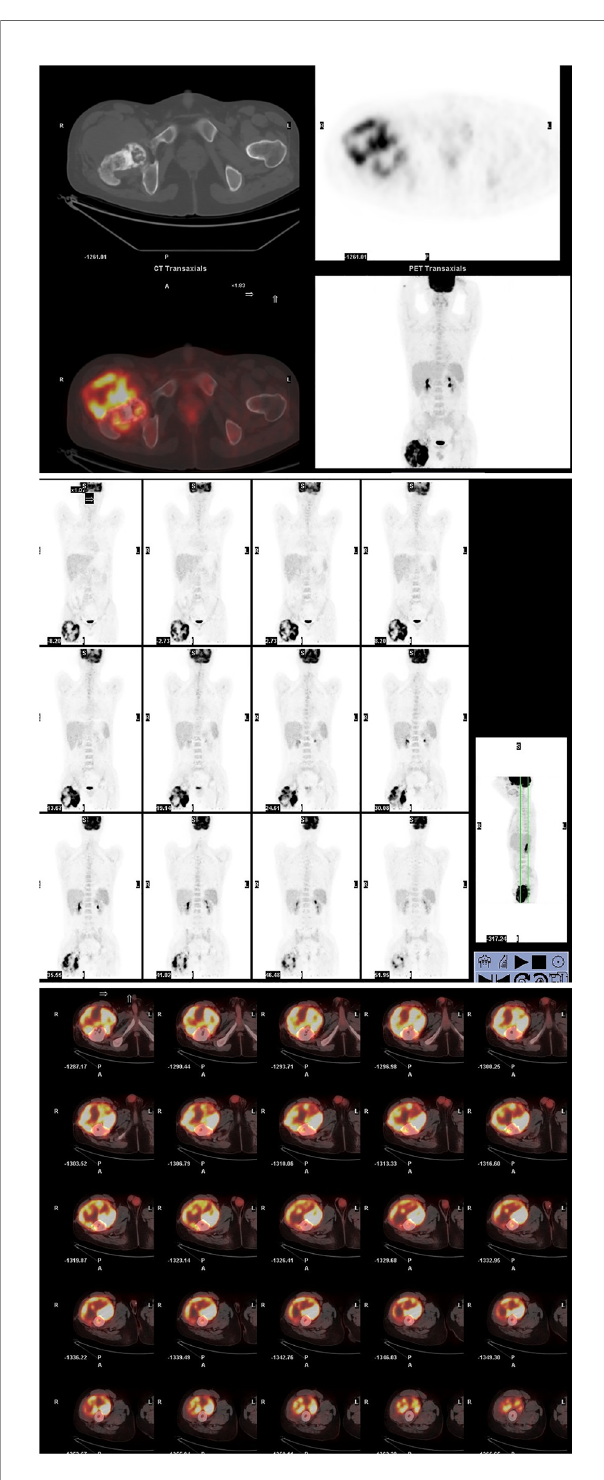
FIGURE 4 | A whole-body tomography positron-emission tomography and computed tomography using 18 F- fl uorodeoxyglucose ( 18 F-FDG) demonstrated a huge cauli fl ower-like appearance skeletal lesion with very high fl uorodeoxyglucose uptake (SUV max 8.0) in the upper segment of right femur. It was noted that the 18 F-FDG avidity was not detected in the lymph nodes or any internal organs.